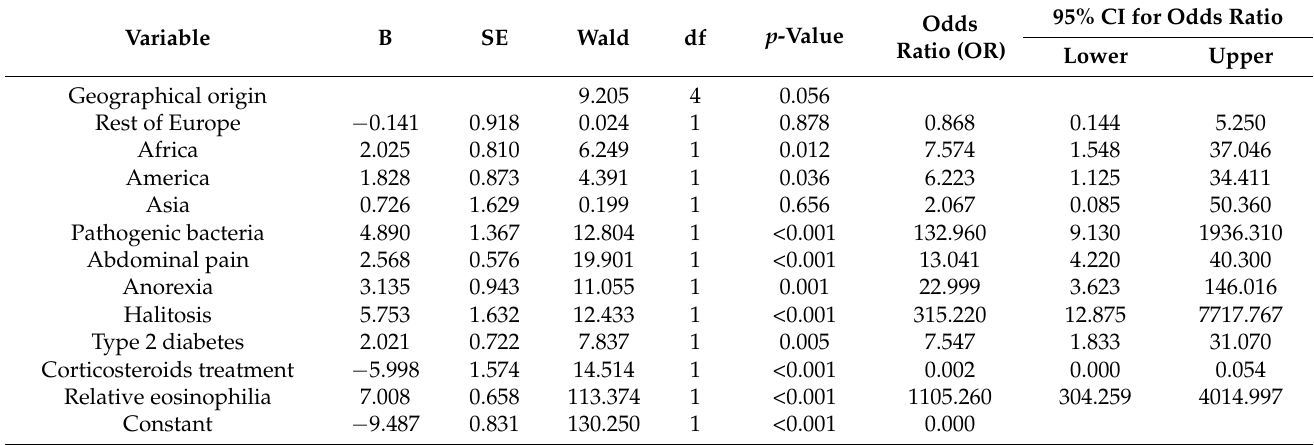
Table 6. Final model for binary logistic regression, showing the significant associations of blastocys- tosis to patient’s origin, presence of pathogenic bacteria, abdominal pain, anorexia, halitosis, type 2 diabetes and corticosteroid treatment, and relative eosinophilia (quantitative